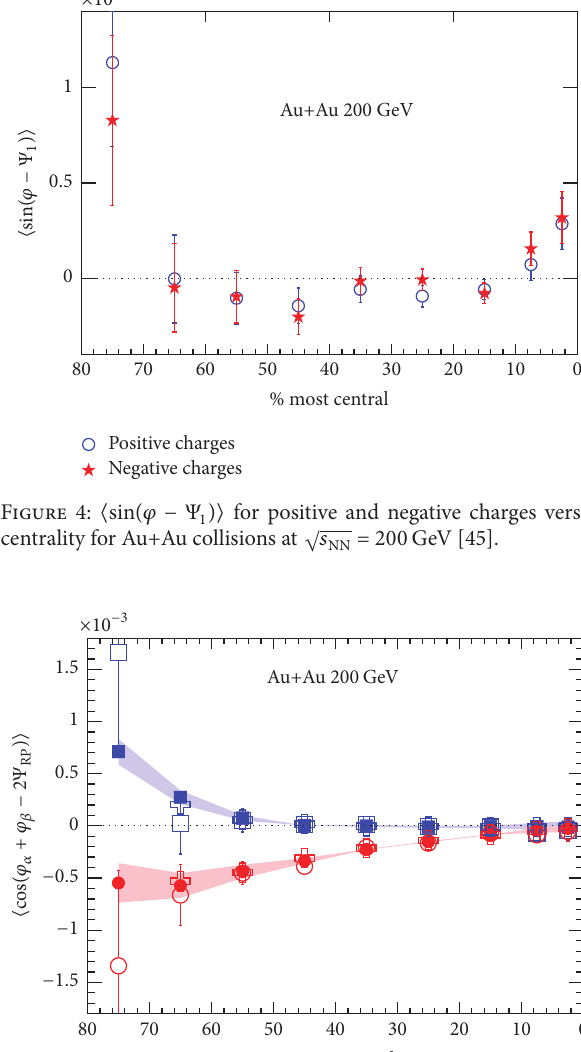
Figure 3: V 1 even of positive and negative particles and the difference between the two as functions of 𝑝 𝑇 in 10–40% Cu+Au and Au+Au collisions [27]. The PHSD model calculations [26] for charged pions with and without the initial electric field (EF) are presented for comparison.